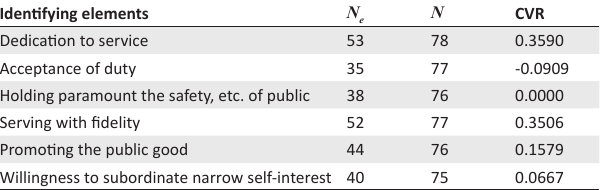
TABLE 12: Content Validity Ratio (Lawshe) of responsibility towards the public or